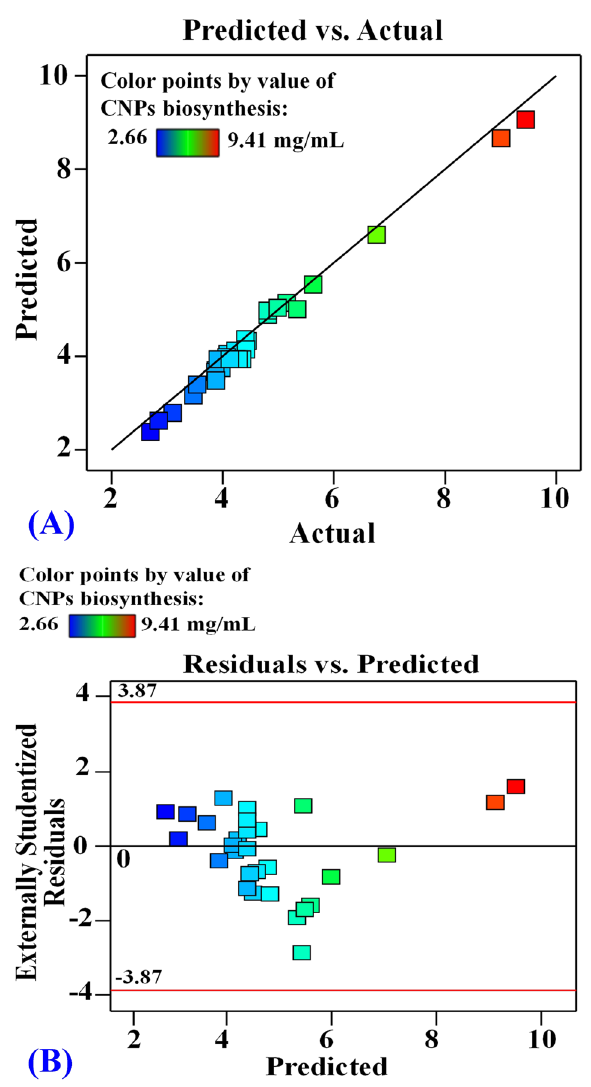
Figure 10. The predicted versus actual ( A ), and ( B ) the residuals versus predicted values of chitosan nanoparticles biosynthesis using Streptomyces microflavus strain